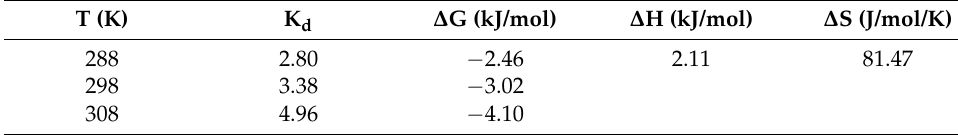
Table 5. Thermodynamic constants of phosphate